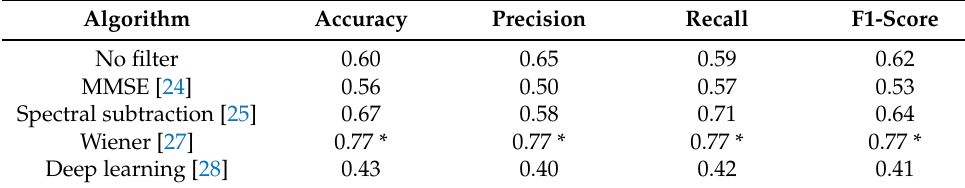
Table 1. Babble Noise SNR 10. * is the best result for each particular measure.